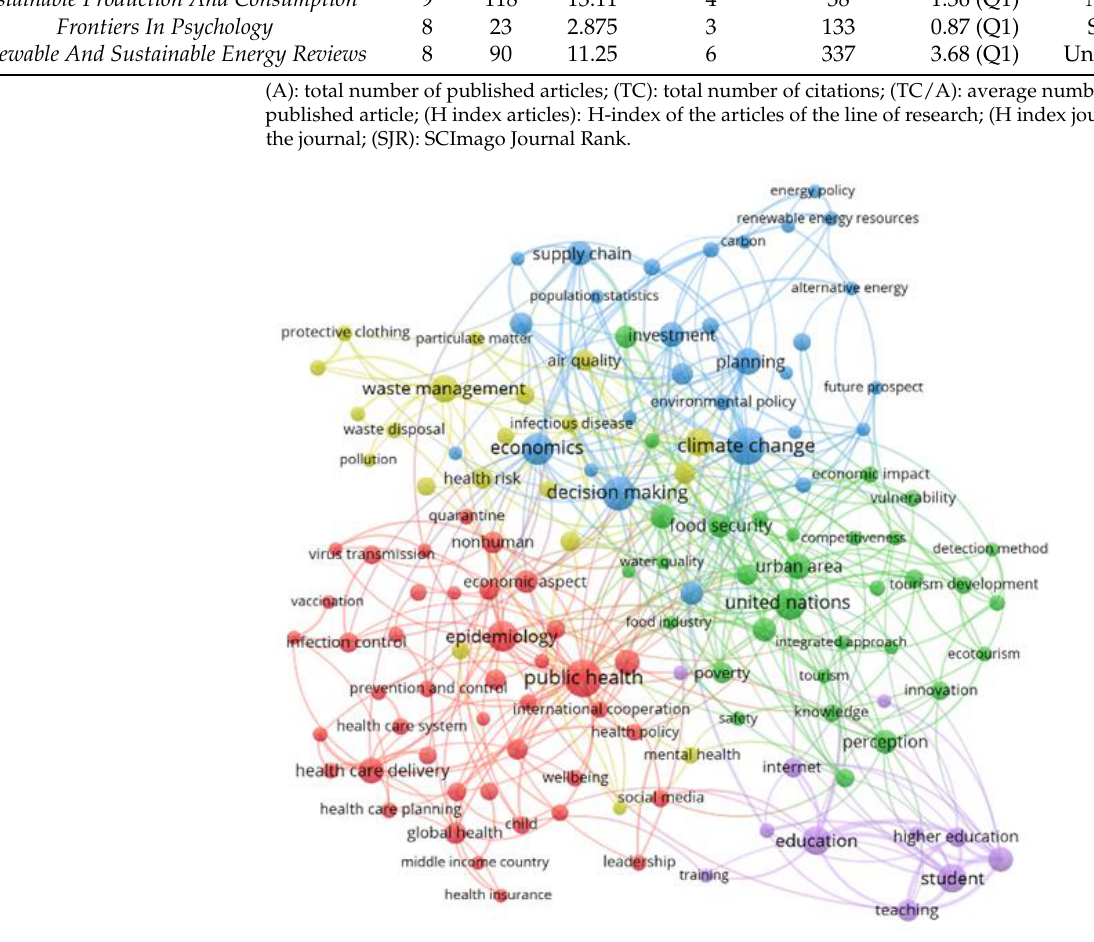
Figure 7. Keywords co-occurrence map.